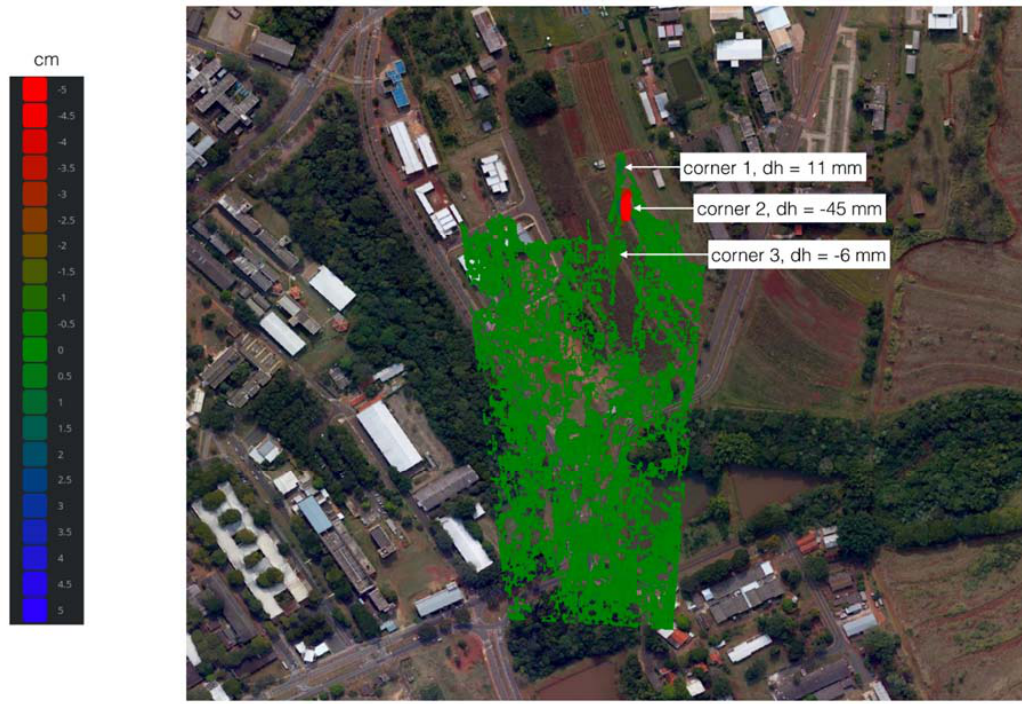
Figure 4. Deformation map of the interferogram 1 and 2—from the first and the second flights. Displacement is positive (dh > 0) when terrain height decreases with time. The coherence threshold is 0.6. Corner reflector 2 was lifted 4 cm in the second flight. The measured displacement was − 45 mm.